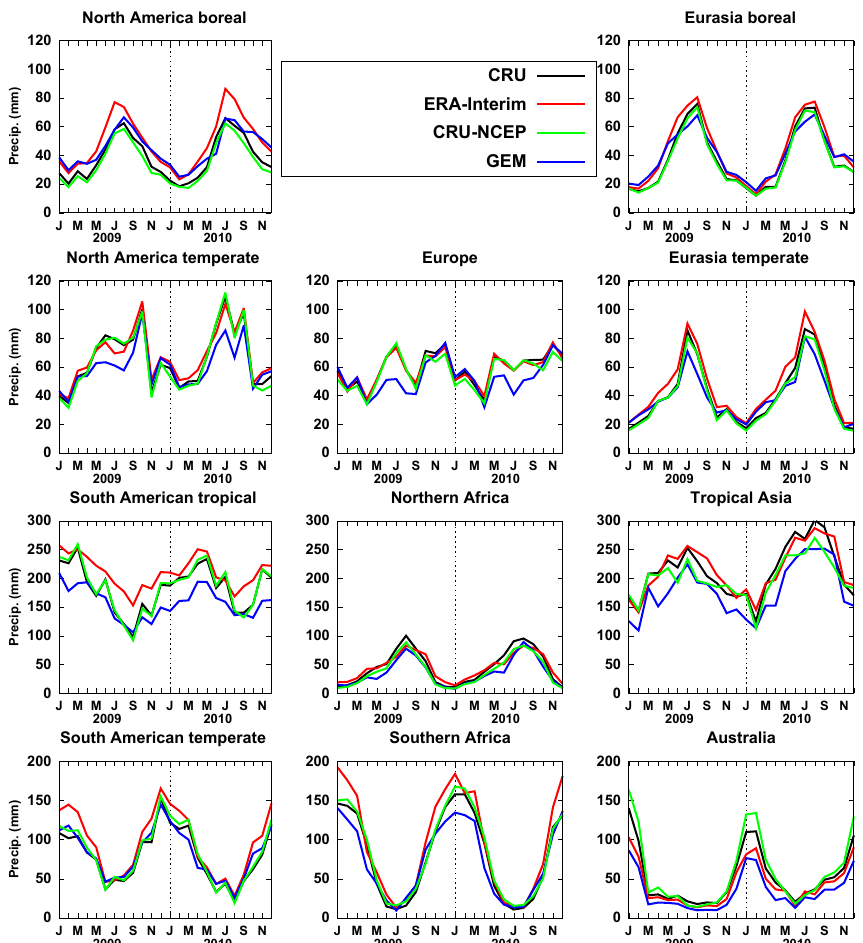
Figure 6. Monthly total precipitation (mmmonth − 1 ) for the 11 TransCom land regions.